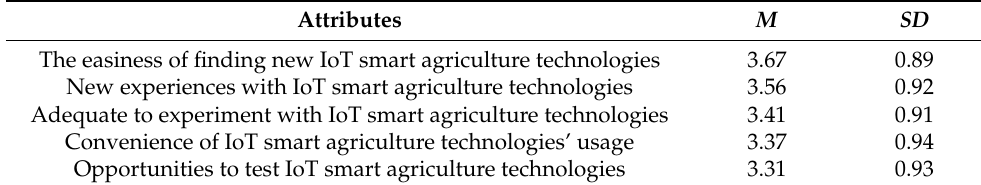
Table 8. Trialability’s Innovation Metrics ( n = 334).